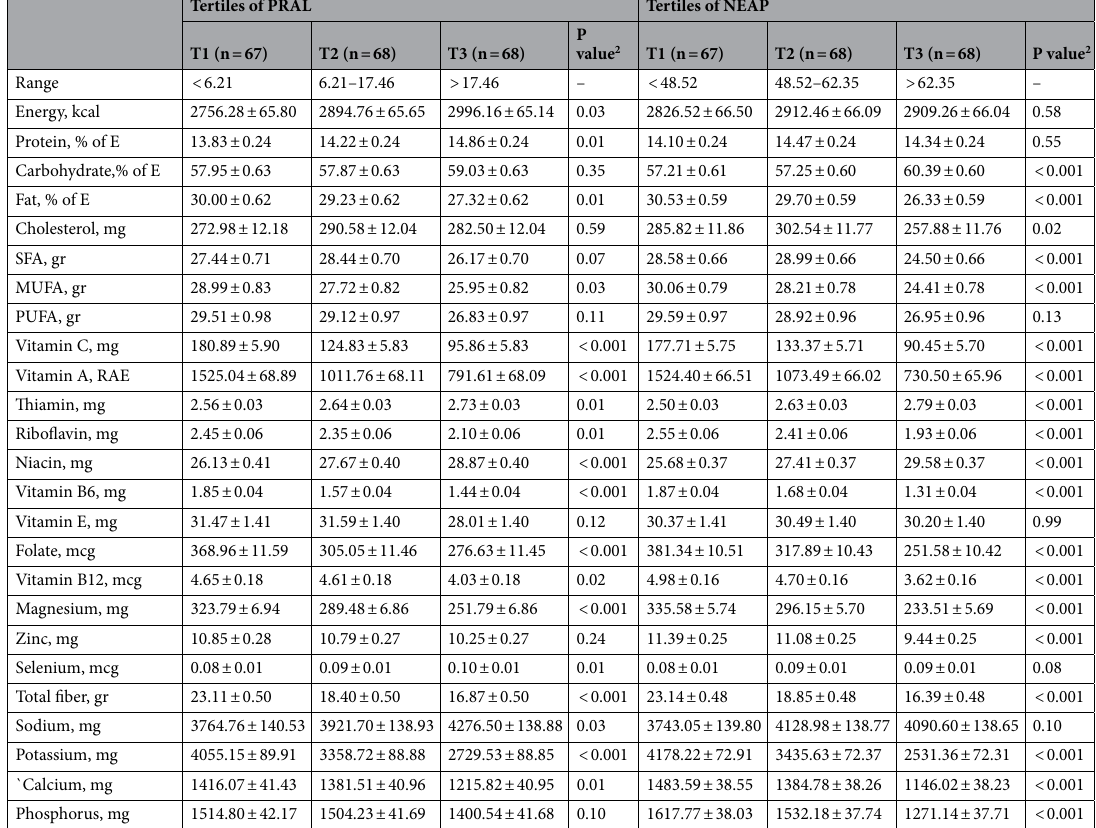
Table 2. Dietary intakes (energy and macro/micro nutrients) of study participants across tertiles of PRAL and NEAP 1 . 1 Values are Mean ± SE. Energy intake, and macro-nutrients (protein, carbohydrate and fat) were adjusted for age and gender; all other values were adjusted for age, gender and energy intake. Abbreviations: NEAP: net endogenous acid production; PRAL: potential renal acid load; E: energy intake; SFA, Saturated fatty acids; MUFA, Monounsaturated fatty acids; PUFA, Polyunsaturated fatty acids. 2 P value obtained from ANCOVA